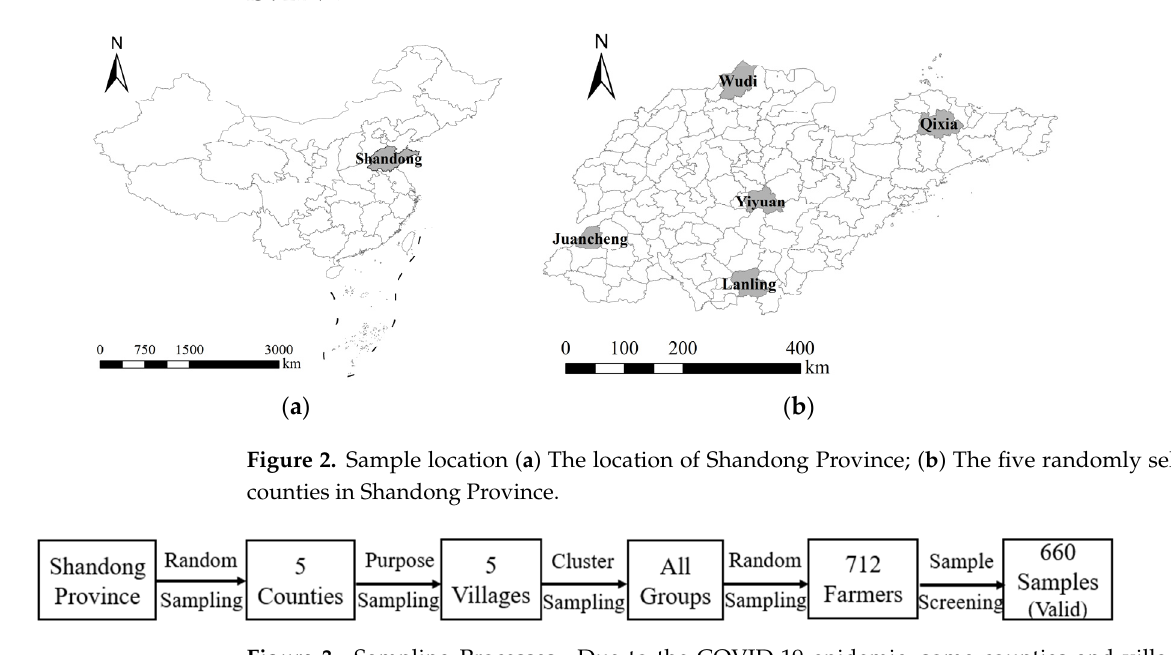
Figure 3. Sampling Processes. Due to the COVID-19 epidemic, some counties and villages in Shandong Province were on lockdown and were automatically excluded from the sampling.